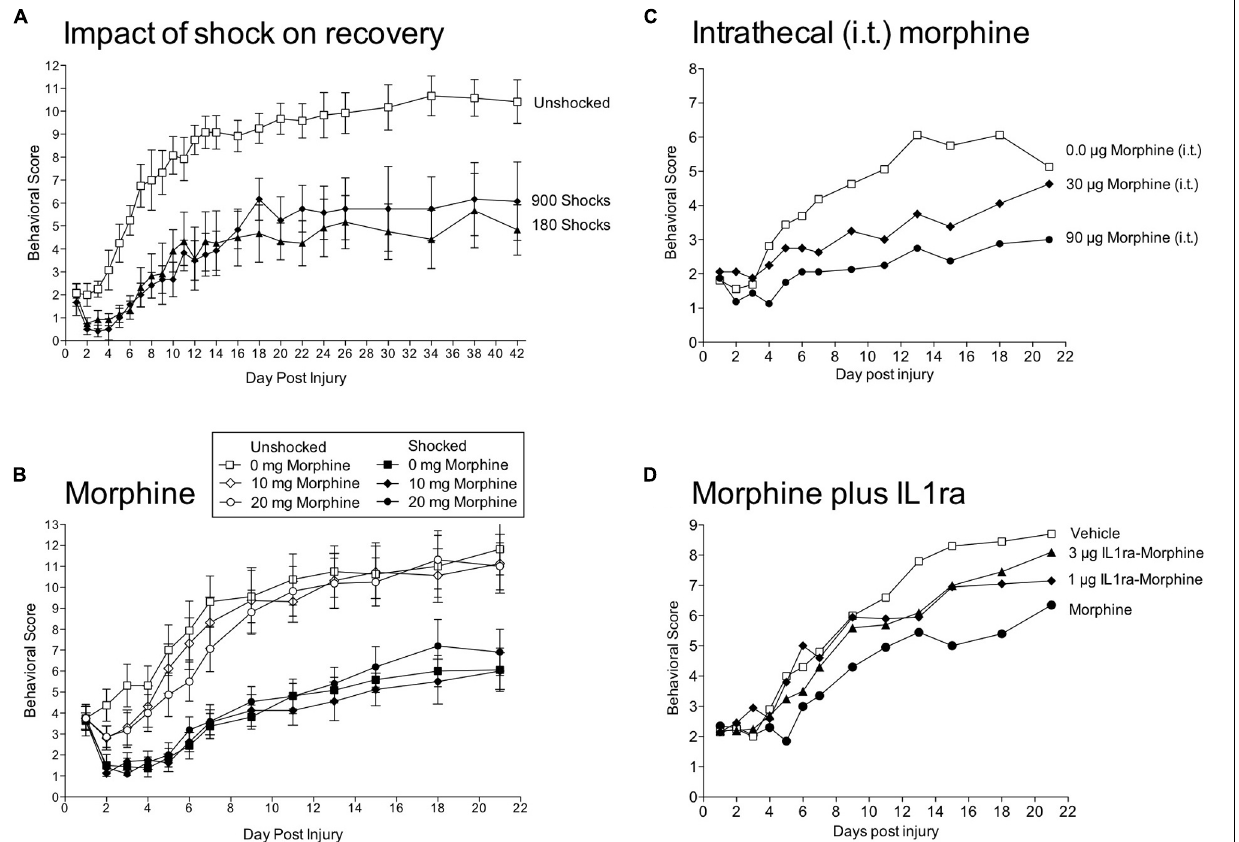
FIGURE 7 | Impact of shock and morphine treatment on recovery after a contusion injury. (A) Rats received a moderate contusion injury and 24 h later VIS (180 or 900 shocks) or nothing (Unshocked). Locomotor recovery was scored over the next six weeks by experimenters that were blind to the subjects experimental treatment using the BBB scale (Basso etal., 1995). Scores were adjusted using the transformation derived by Ferguson etal. (2004), which improves the metric properties of the scale. Shock treatment impaired the recovery of locomotor function. (B) Contused rats were given morphine [0, 10, or 20 mg, intraperitoneal (i.p.)] followed by VIS (Shocked) or nothing (Unshocked). Behavioral observations confirmed